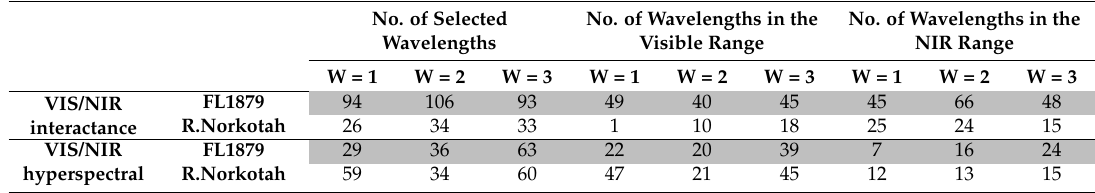
Table 2. Number of selected wavelengths using the interval partial least squares (IPLS) technique for primordial leaf count, using data obtained from VIS/NIR interactance and hyperspectral imaging systems for Frito Lay 1879 (FL1879) and Russet Norkotah (R.Norkotah) potato cultivars. Shaded cells show optimal